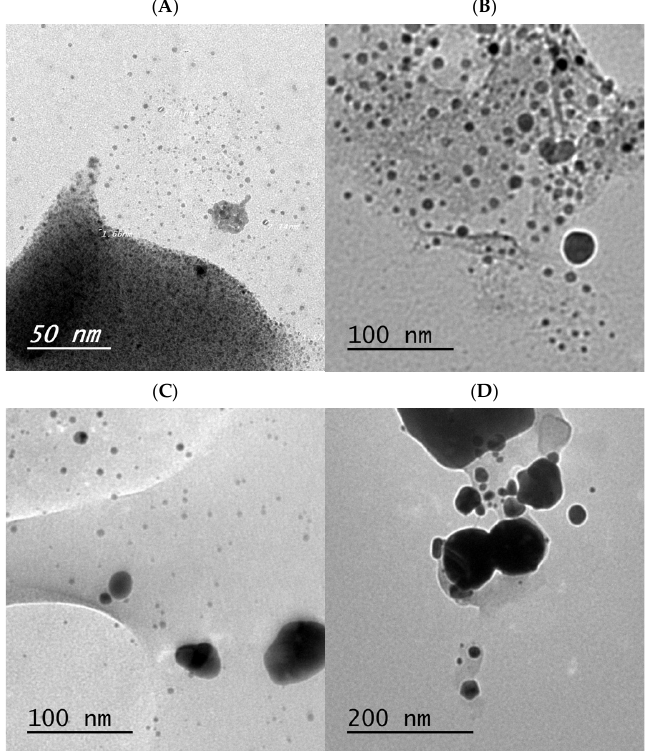
Figure 5. TEM images of ( A ): Mg(II), ( B ): Ca(II), ( C ): Zn(II), and ( D ): Fe(III)–pip complexes.